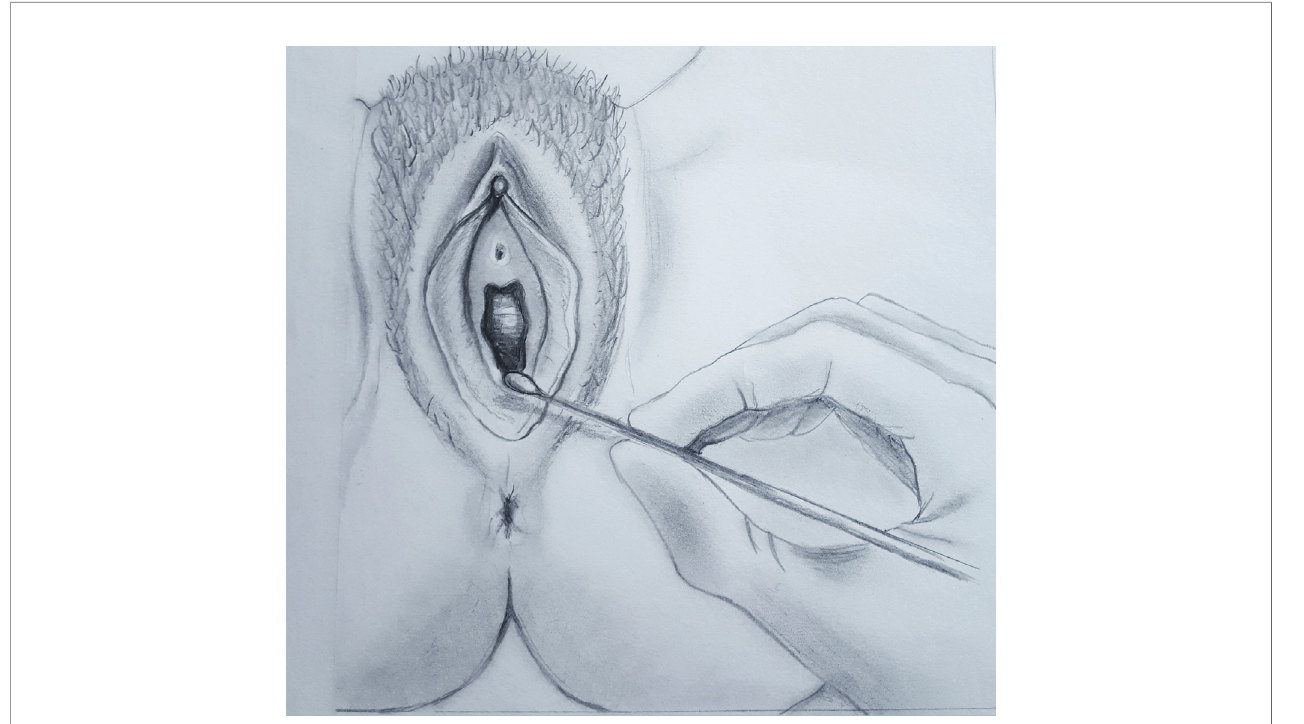
FIGURE 1 | Q-tip test. Vestibular point tenderness is tested at 2-, 5-, 6-, 7-, and 10-o ’ clock positions, and quanti fi ed as mild, moderate, or